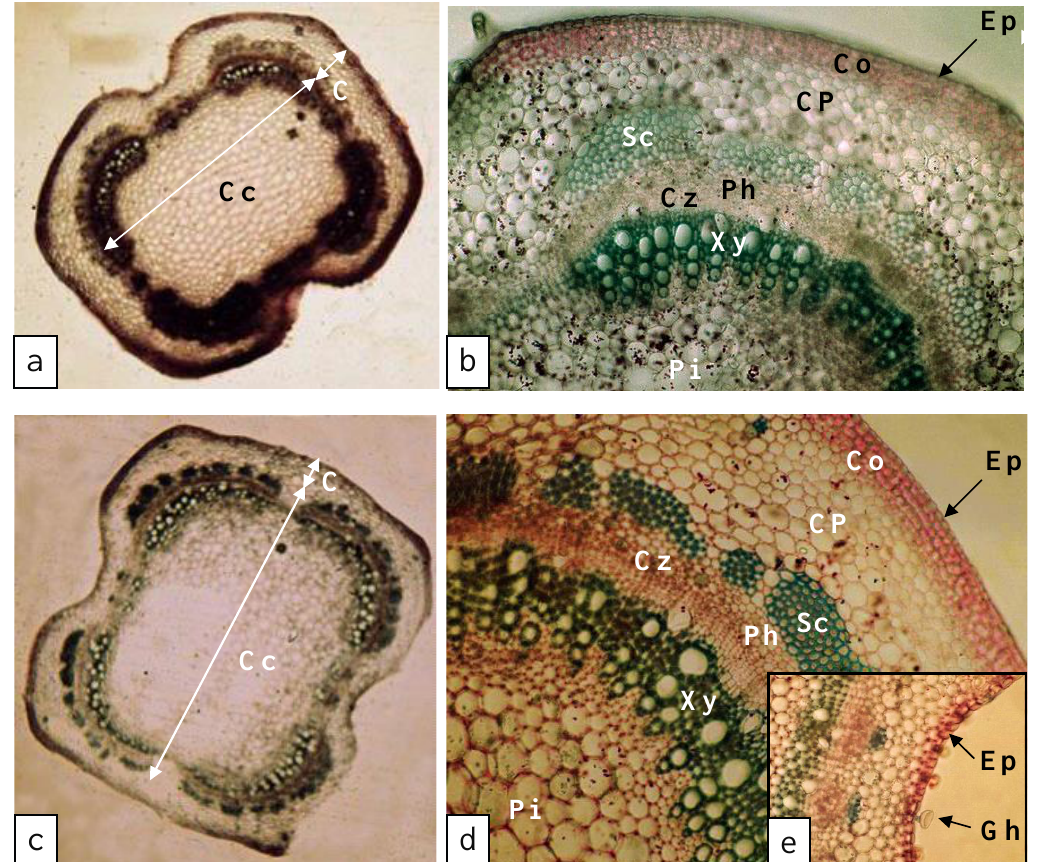
Figure 7. Transverse sections of O. basilicum stems of 64-day-old plants grown for 30 days in the presence of varying K + concentrations. Fixation in F.A.A. and carmine-green staining. ( a ) Overall view of the stem at 0.375 mM K + (×50). ( b ) Detail of Figure 7a (×231). ( c ) Overall view of the stem at 0.25 mM K + (×50). ( d ) Detail of Figure 7c (×235). ( e ) Detail of Figure 7d (×398). Abbreviations: Cz — cambial zone; Cc — central cylinder; C — cortex; Co — collenchyma; CP — cortical parenchyma; Ep — epidermis; Fi — fibers; Gh — glandular hairs; Sc — sclerotized tissue; Ph — phloem; Pi — pith; Xy — xy- lem.